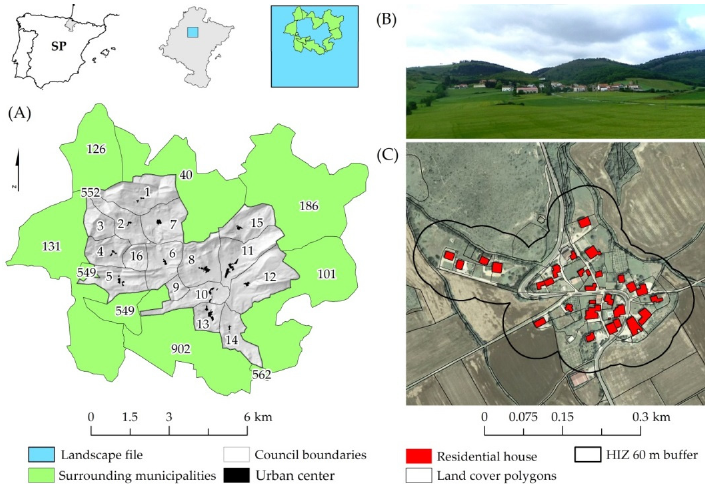
Figure 1. Location of the Juslapeña Valley (3163 ha) in central Navarra (Spain) ( A ). The numbers refer to the regional cadaster council polygon (1 to 16) and municipality code ( B ). The 36,000-ha wildfire modeling domain framed by the landscape file (LCP) encompassing the study area had a wider extension to the south to account for incoming fires from the fire-prone areas of central Navarra. Land covers in the cultural landscapes present sharp edges in vegetation ( B urban center of the council No. 8). Detailed cartography and cadaster polygons (scale 1/5000) were used to generate surface fuel maps (sigpac.navarra.es) and locate residential houses (catastro.navarra.es) ( C ). The HIZ is the 60-m buffer around structures [11], and was calculated for each residential house to conduct this study. In the figure ( C ) we show the external HIZ contour of the residential houses in urban center of the council No.